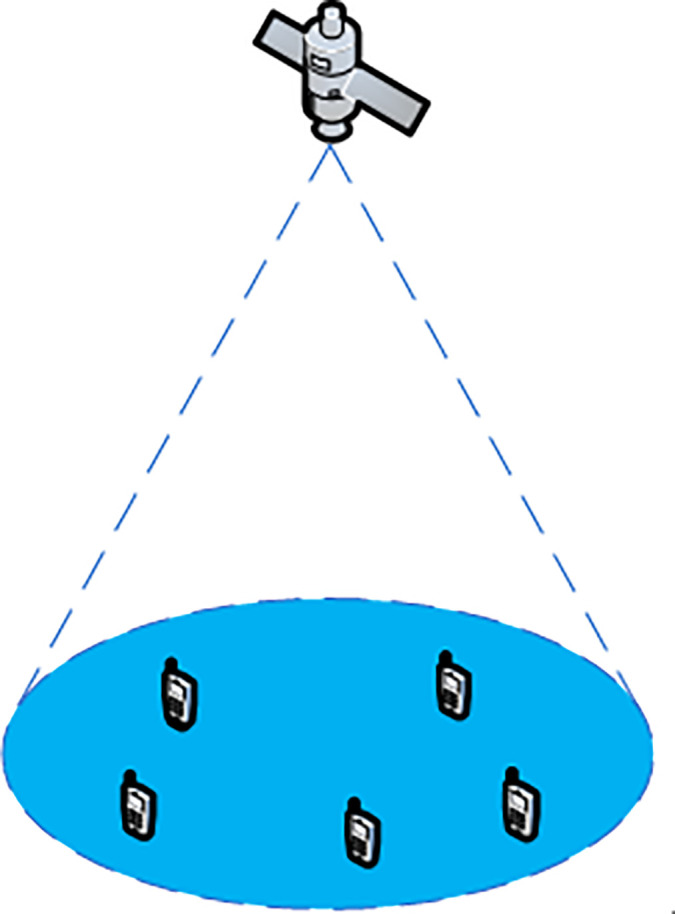
Simulation scenario.